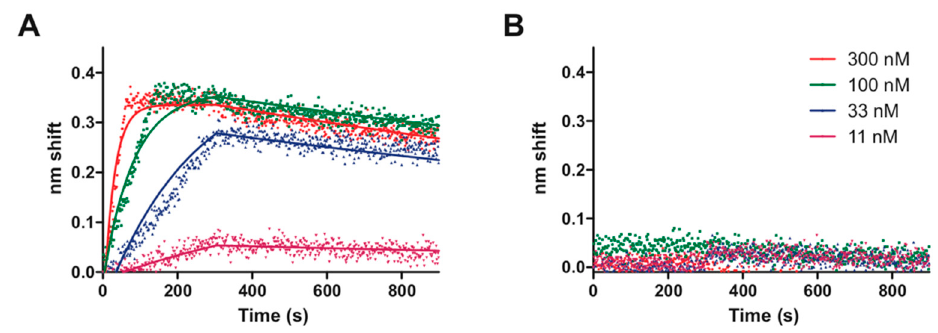
Figure 4. Biolayer interferometry analysis of TTHA0973 binding to DNA. Shown are raw traces (dots) and best-fit lines of TTHA0973 binding to ( A ) ST2_0973_R5_wt consensus DNA or ( B ) ST2_REPSAis control DNA. TTHA0973 concentrations investigated include 300 nM (red), 100 nM (green), 33 nM (blue), and 11 nM (magenta).